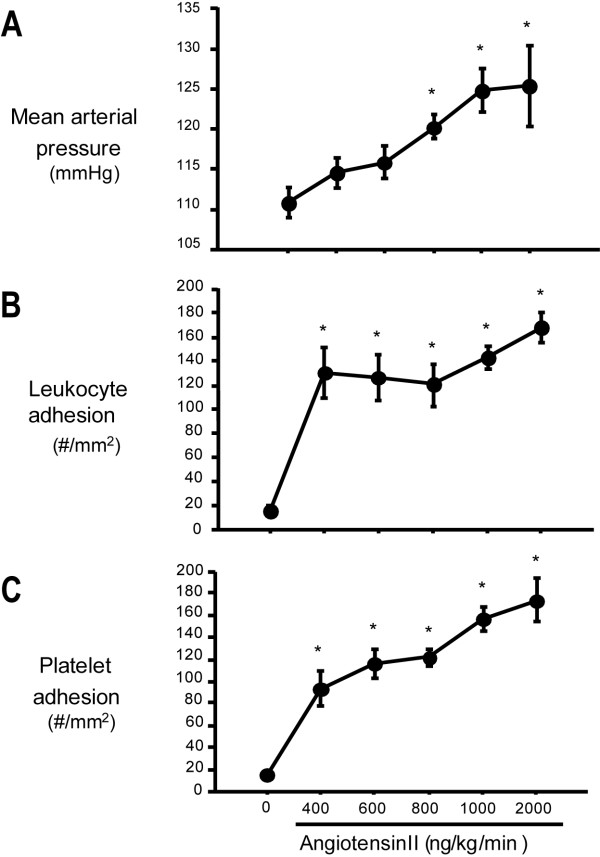
Chronic Ang II infusion elicits dose-dependent increases in blood pressure and the adhesion of leukocytes and platelets in cerebral venules. WT mice received a 14-day infusion of Ang II subcutaneously in pumps loaded to deliver either 0, 400, 600, 800, 1000, or 2000 ng/Kg/min. (Panel A): Mean arterial blood pressure was measured in conscious mice with an indwelling femoral arterial catheter. (Panels B & C): The adhesion of leukocytes (B) and platelets (C) in cerebral venules was monitored via a cranial window by fluorescence intravital videomicroscopy. Leukocytes were labeled in vivo with Rhodamin 6G while platelets were labeled with CFDSE ex vivo. Data are shown as mean ± SEM for 6-13 mice per Ang II dose. * denotes p < 0.05 relative to saline infusion.